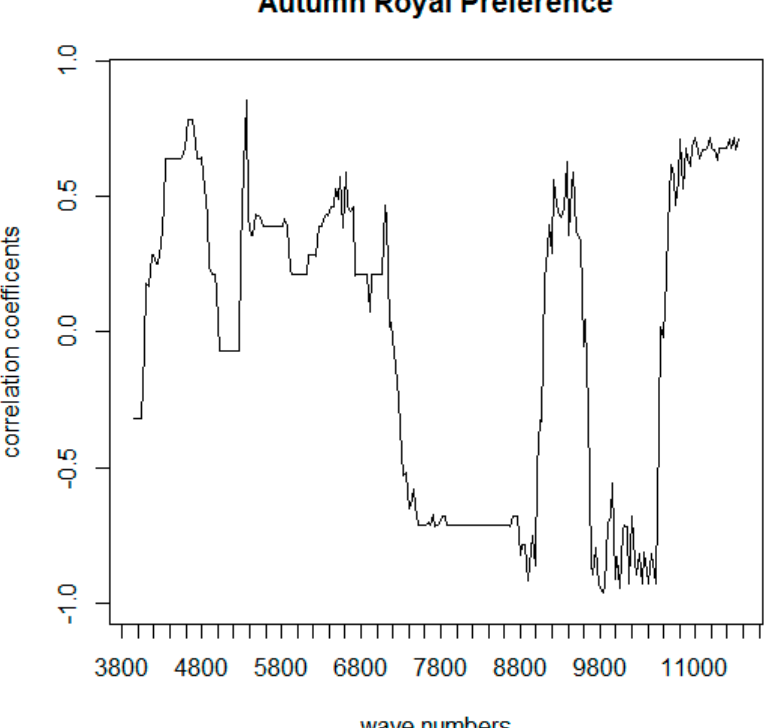
Figure 6. Correlogram: correlation coefficients between FT-NIR spectroscopic data and the sensory data “preference” of “Autumn Royal” grape.